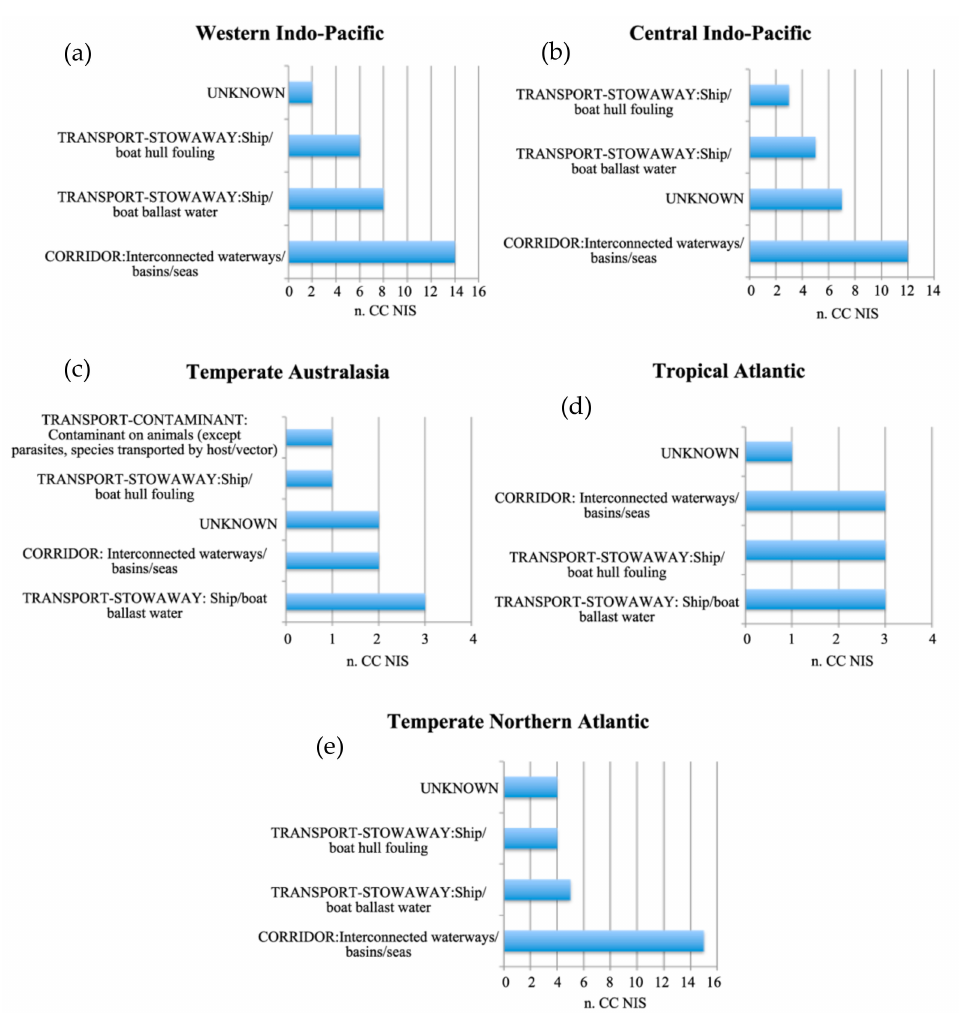
Figure 2. Number of CC NIS introduced in the Mediterranean Sea through primary introduction pathways, based on CBD [44] scheme associated with each of five major realms of Mediterranean CC NIS’s native distribution: ( a ) Western Indo-Pacific, ( b ) Central Indo-Pacific, ( c ) Temperate Australasia, ( d ) Tropical Atlantic, ( e ) Temperate Northern Atlantic. Several species are linked to more than one